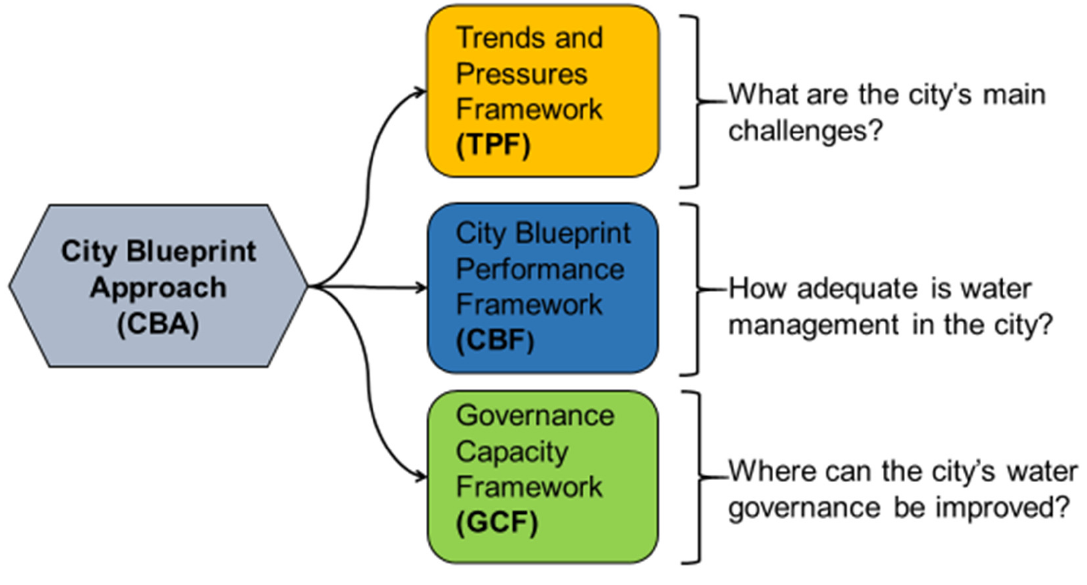
Figure 4. City Blueprint Approach [14–16].